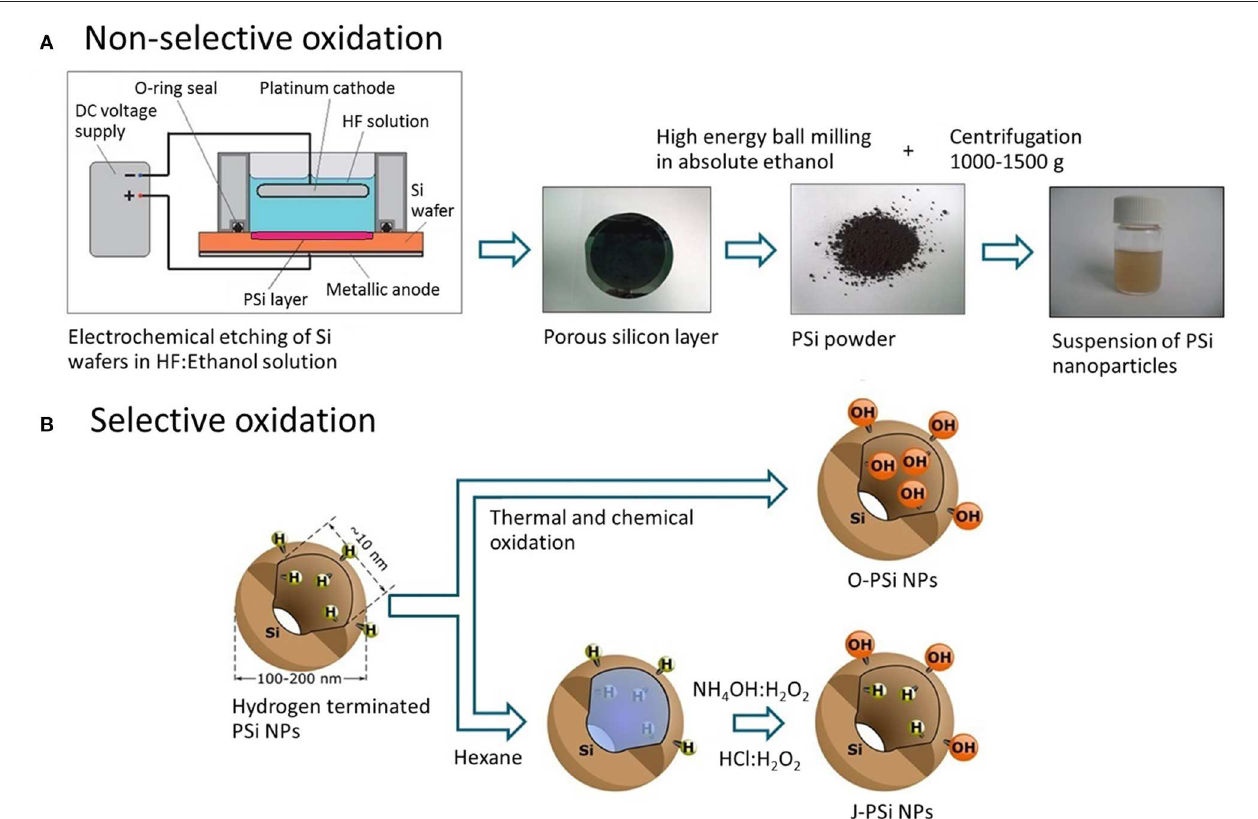
FIGURE 1 | (A) Fabrication route of PSi NPs: Electrochemical etching of the silicon wafer, grinding of the free-standing PSi film, ball milling of the PSi powder in ethanol, and centrifugation to obtain the nanoparticle suspension. (B) Techniques of the PSi NP surface modification: Thermal oxidization (O-PSi NPs) and selective modification (J-PSi NPs) using hexane as a